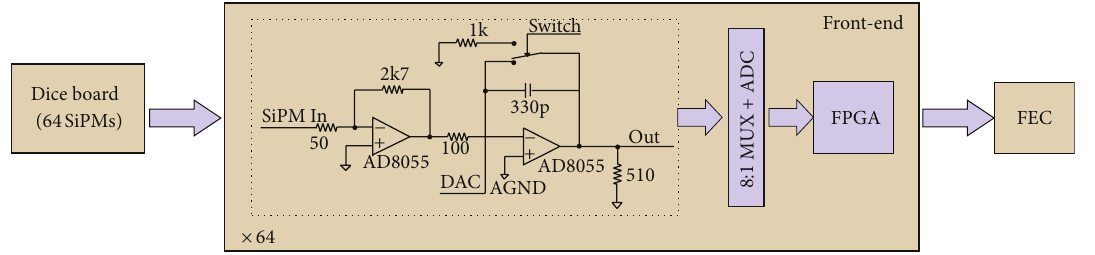
Figure 17: Scheme of the front-end for the tracking plane.